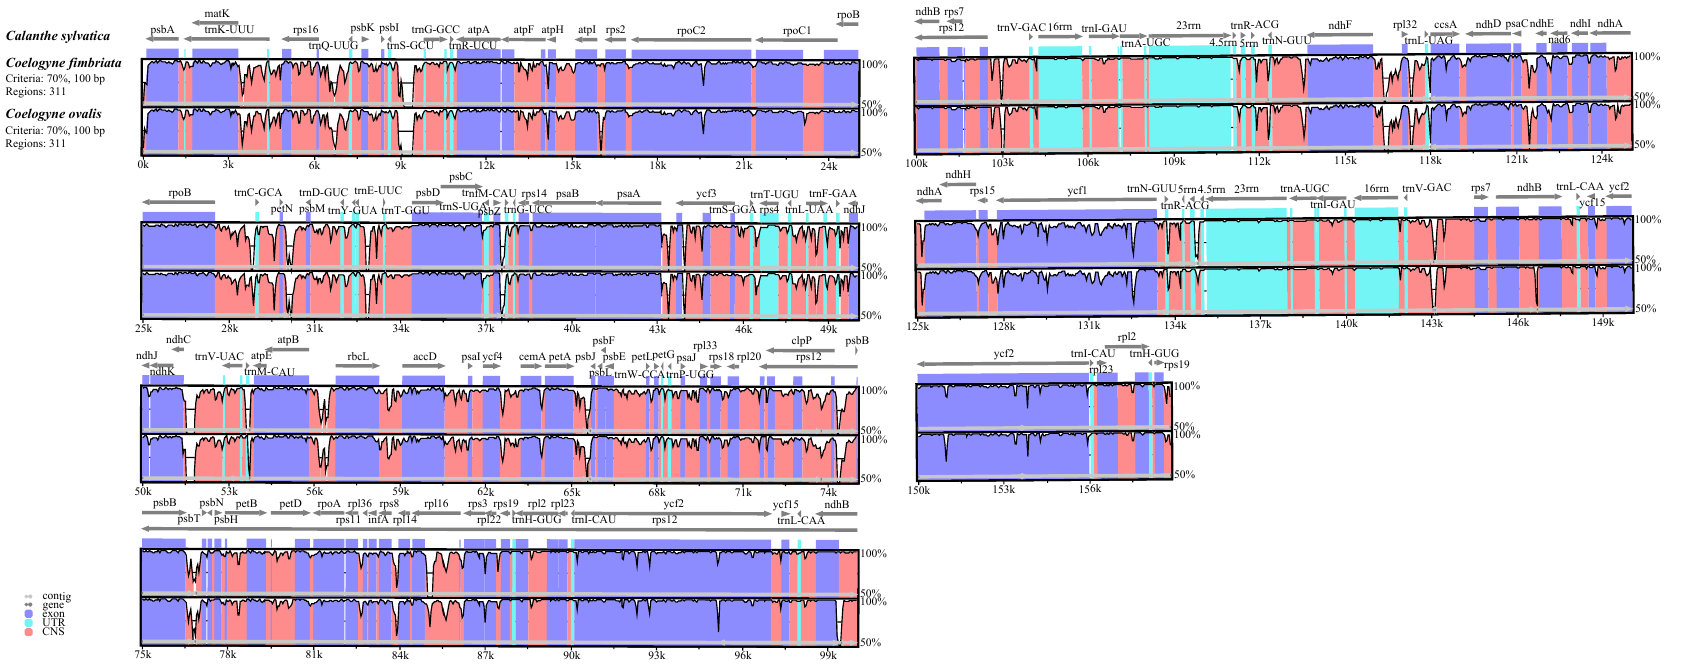
Figure A1. The cp genome sequence comparison of two Coelogyne species with Calanthe sylvatica as a reference. Dark grey arrows show the direction and position of genes. Pink and dark blue areas show Conserved Non-coding Sequences (CNS) and exon regions, respectively. The untranslated regions (UTRs) are colored with light-blue, including tRNA and rRNA regions. The peaks and valleys show the percent of conservation with an identity cuto ff of